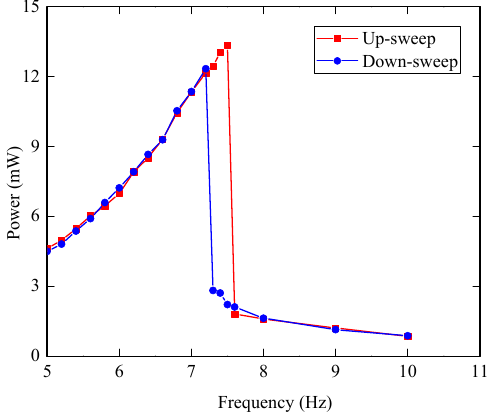
Figure 14. Output power versus excitation frequency with up-sweep and down-sweep.